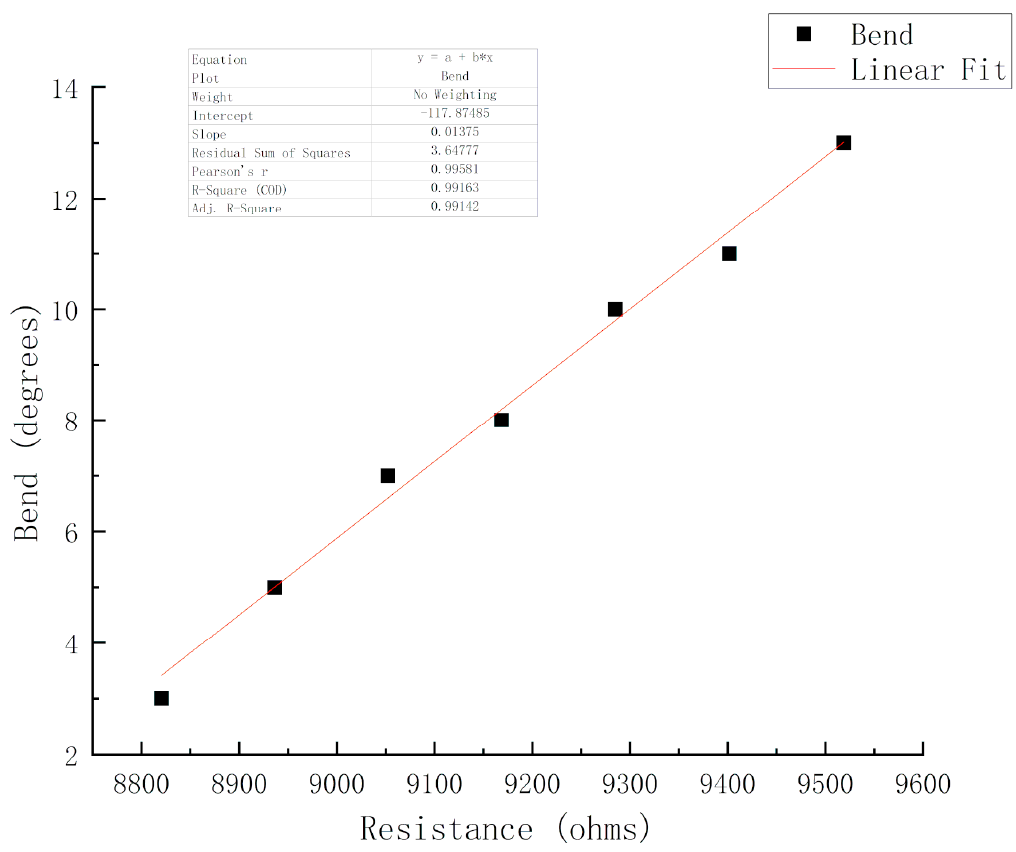
Figure 9. Linear fitting of experimental results.